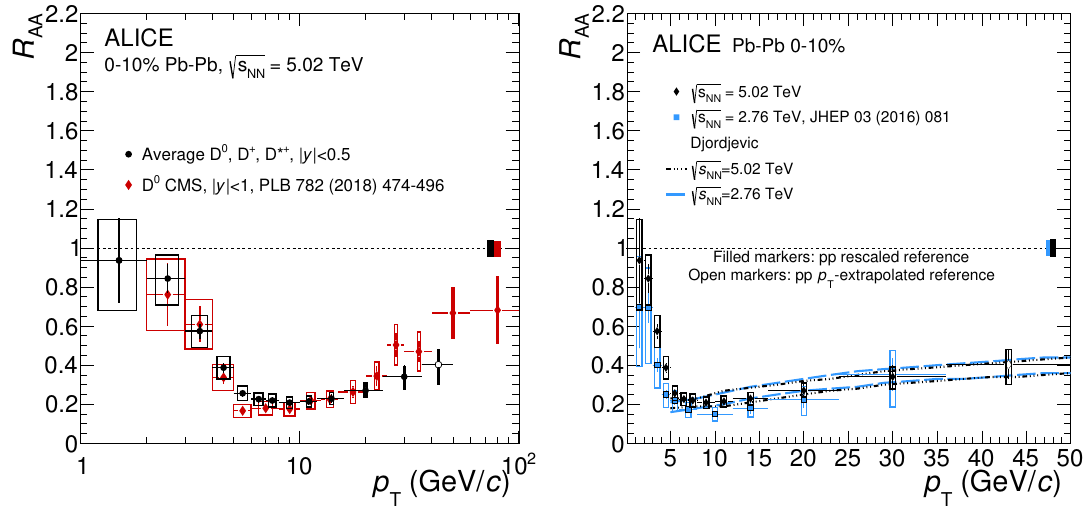
Figure 6 . Left panel: average R AA of prompt D 0 , D + and D (cid:3) + mesons by ALICE compared to R AA of prompt D 0 mesons by CMS [26] in the 0{10% centrality class and at (bars), systematic (empty boxes), and normalisation (shaded box around unity) uncertainties are shown. Right panel: average R AA of D 0 , D + and D (cid:3) + mesons compared with the Djordjevic model [54] in the 0{10% centrality class at two collision energies. Statistical (bars), systematic (empty boxes), and normalisation (shaded box) uncertainties are shown.